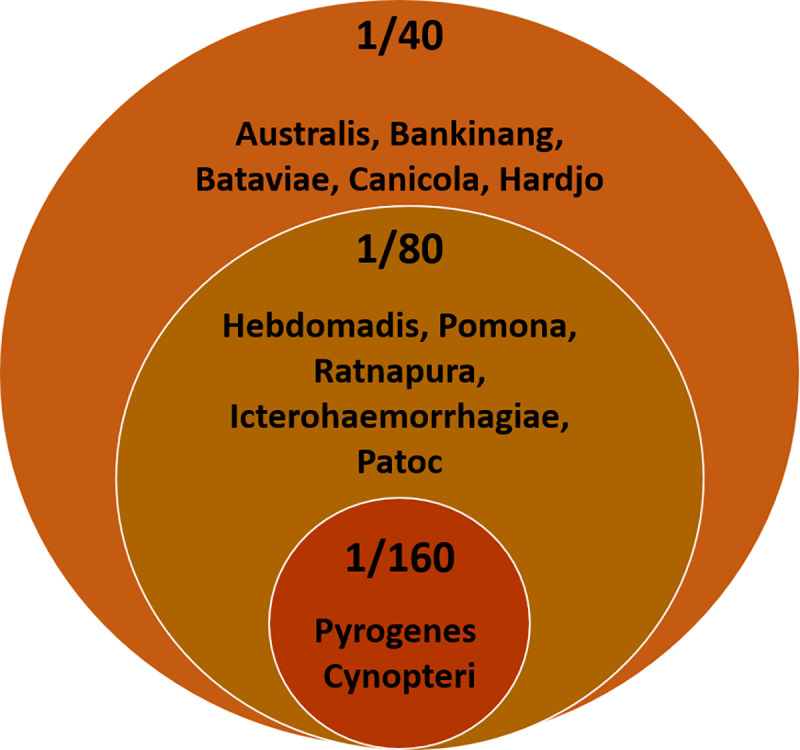
Suggested diagnostic cut-off titres for different serovars.